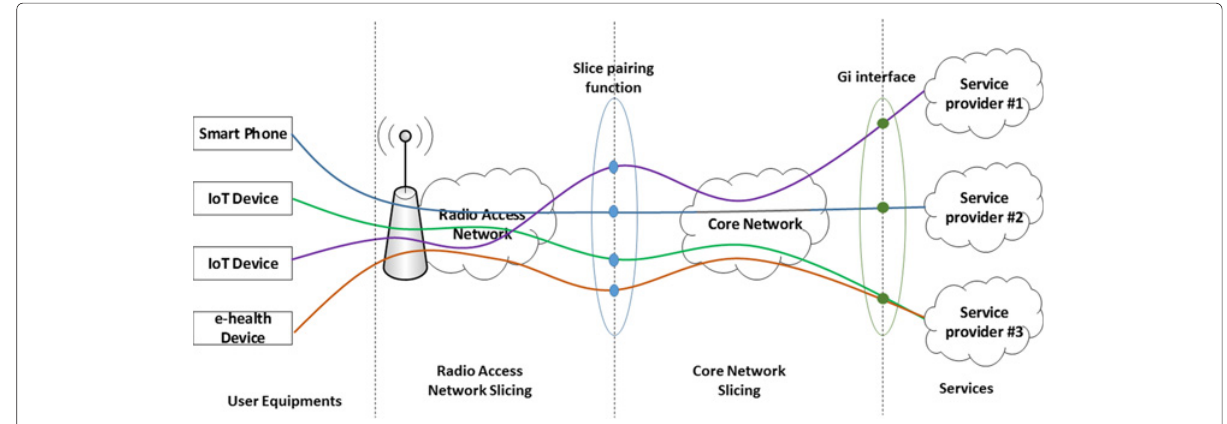
Fig. 5 The slice chaining concept, based on